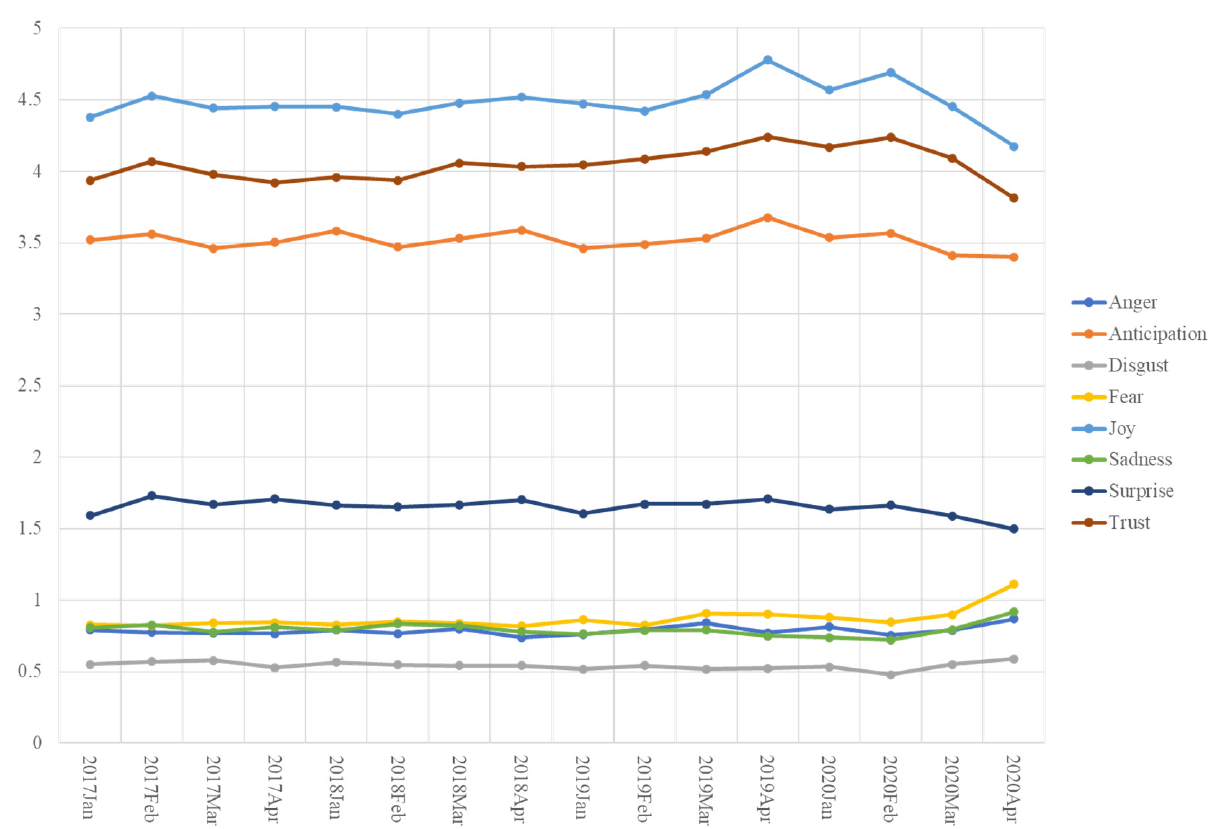
Figure 6. Eight Emotions Comparison by Month.